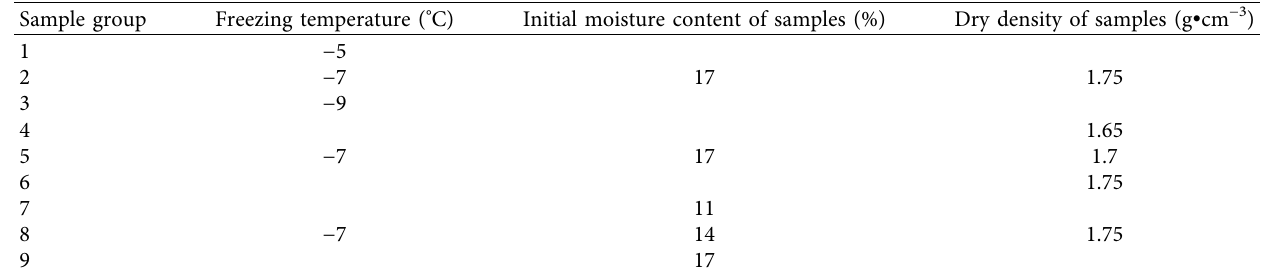
Table 2: The experimental